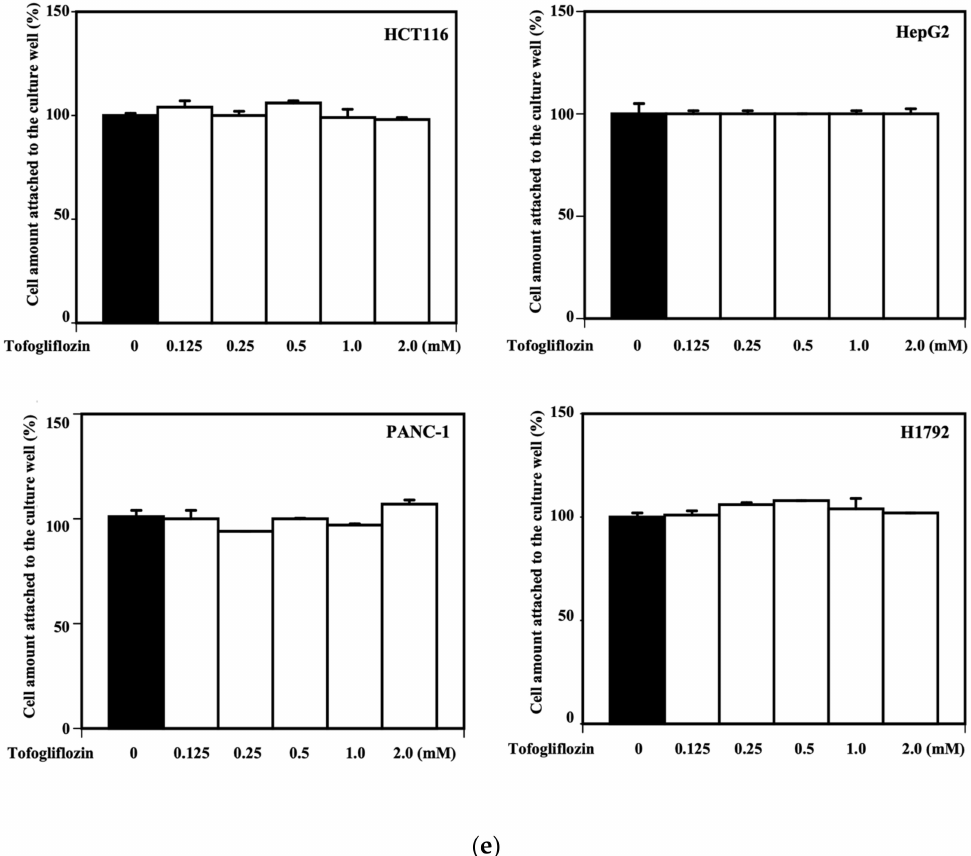
Figure 1. Relative sensitivities of HCT116 and HepG2 cells to dapagliflozin treatment. ( a ) Time-course e ff ects of dapagliflozin treatment on HCT116 cell morphology and cell attachment. The HCT116 cells were treated with vehicle (DMSO) or 0.5 mM dapagliflozin for the times indicated. Please note that 25 min treatment with 0.5 mM dapagliflozin let HCT116 cells be lifted o ff the dish as a sheet and